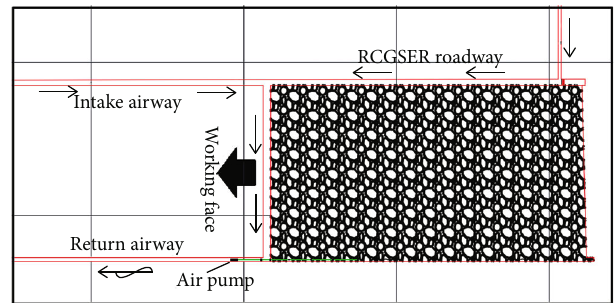
Figure 1: I2101 working face roadway layout.